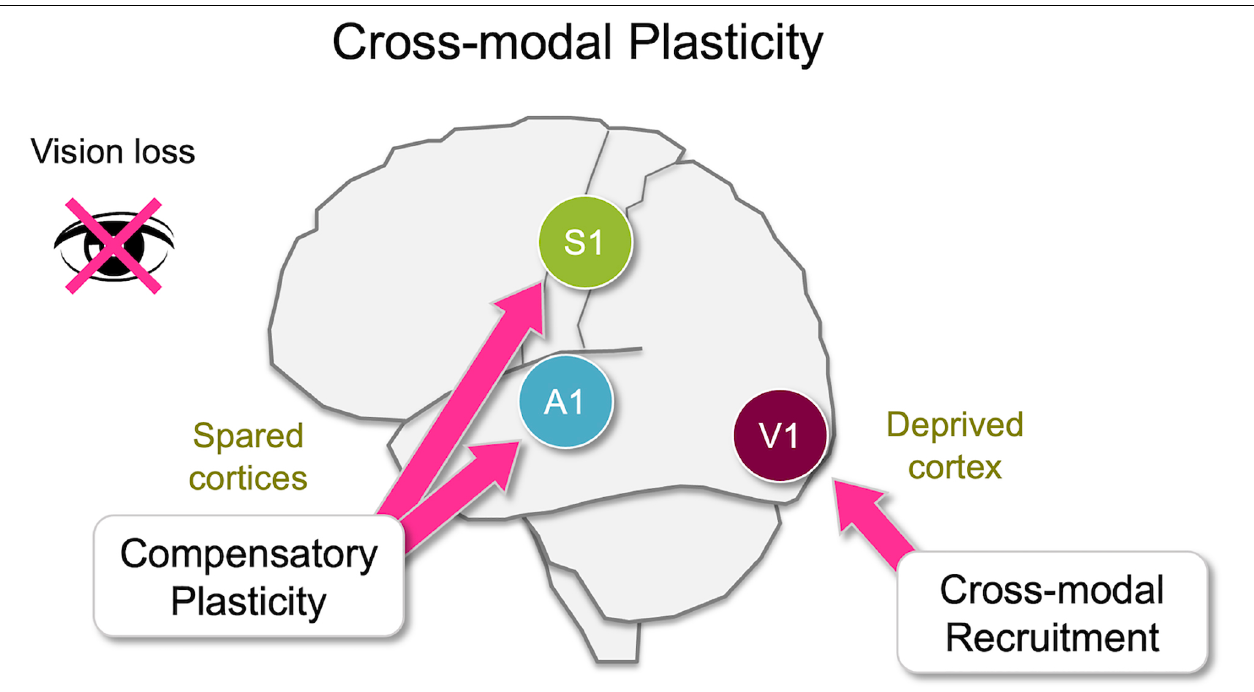
FIGURE 1 | Overview of cross-modal plasticity. Loss of a sensory modality, such as vision, triggers widespread adaptation across different brain areas referred to as cross-modal plasticity. Largely there are two distinct aspects of cross-modal plasticity: cross-modal recruitment and compensatory plasticity. The former involves recruitment of the deprived sensory cortex by the remaining senses, and the latter is manifested as a functional refinement of the spared sensory cortices. While many brain areas are involved in cross-modal plasticity, some of these changes manifest as plasticity at the level of the primary sensory cortices. In this review, we will discuss various cortical and subcortical pathways that are potentially involved in cross-modal plasticity of primary sensory cortices following loss of vision primarily focusing on functional connectivity of the mouse